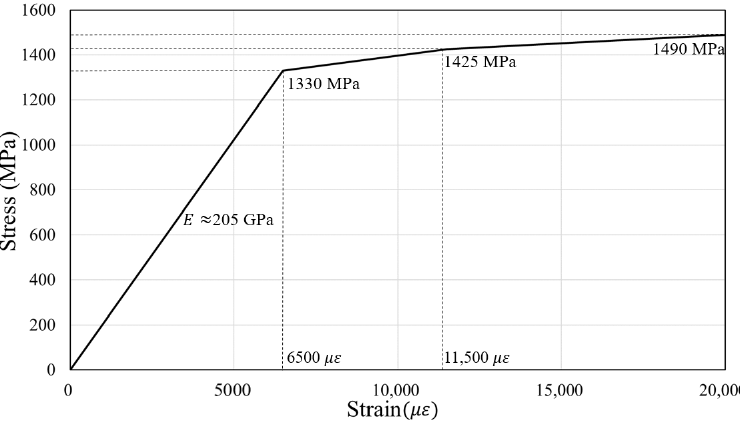
Figure 8. Properties of the input material.